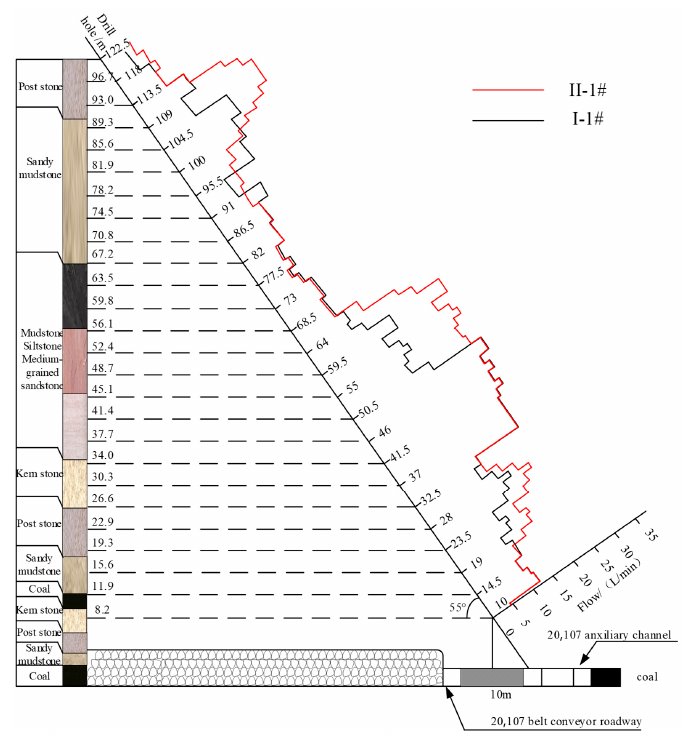
Figure 10. I-1# and II-1# Borehole Leakage Histogram.